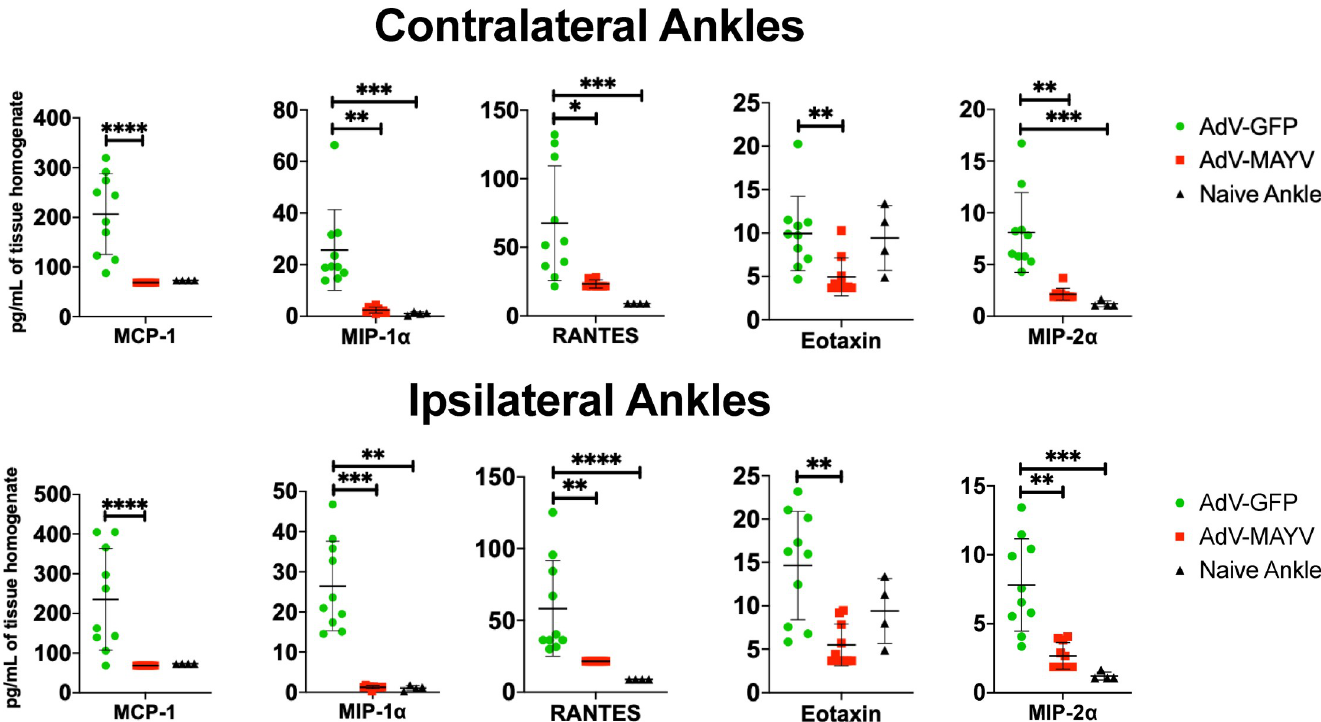
Fig 5. MAYV-AdV Vaccination Reduces Inflammatory Mediators in the Joint. Levels of cytokines and chemokines in control mice and mice challenged with MAYV following vaccination with AdV-GFP and AdV-MAYV. WT C57BL/6N mice were vaccinated with AdV-MAYV or AdV-GFP by i.m. injection followed by a booster vaccinated at 14 days. At day 28 post vaccination, mice were challenged with 1x10 4 PFU/ml MAYV BeAr in the right footpad (n = 10 mice per group). Ankle tissue homogenates collected from mice at 4 dpi were analyzed for cytokine and chemokines by a 26-plex cytokine multiplex kit and compared to na ï ve tissues. Statistical analysis was performed using Kruskal-Wallis tests and error bars represent SD ( � P < 0.05, �� P < 0.005, ��� P = 0.0001, ���� P <